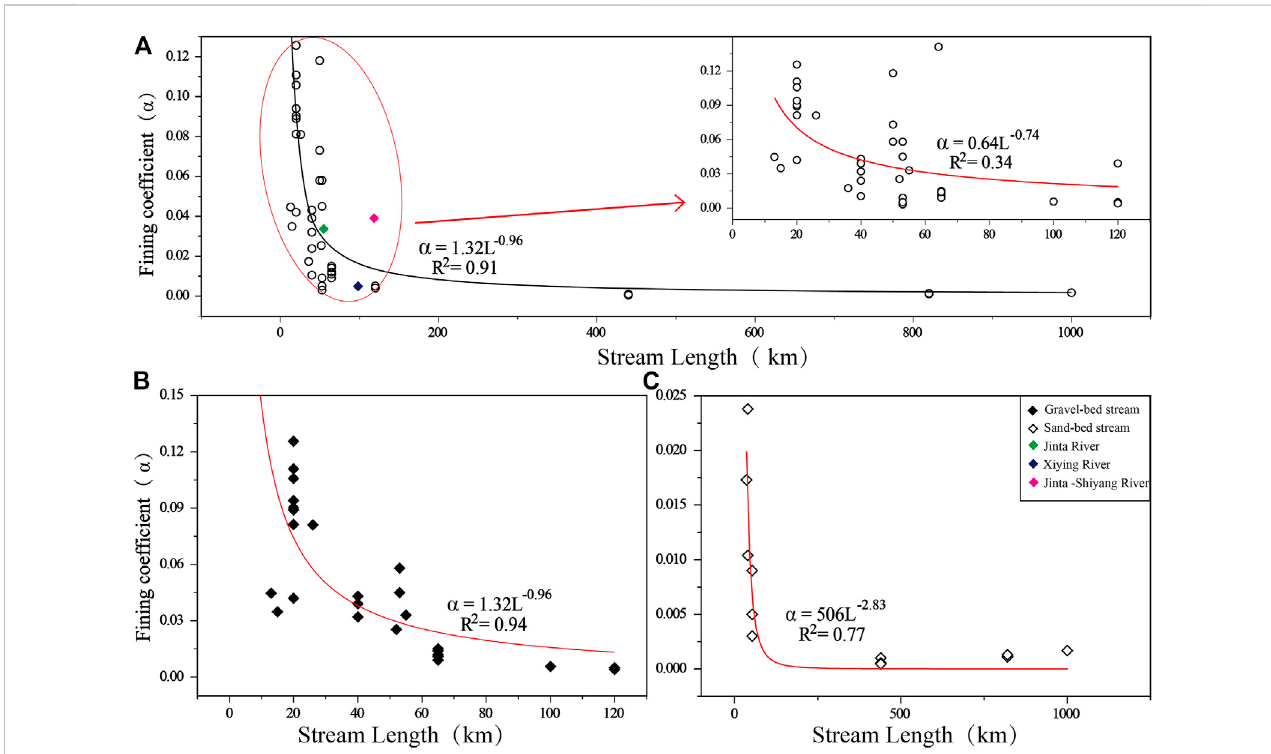
FIGURE 4 Relationship between river length and re fi nement index of some rivers in the world (A) . Red solid line is the fi tting result. The sub-graph shows the relationship between river length and sediment re fi nement index within 120 km of stream length. (B,C) indicate relationships between river length and sediment particle size re fi nement index of some gravel-bed, and sand-bed streams in the world,